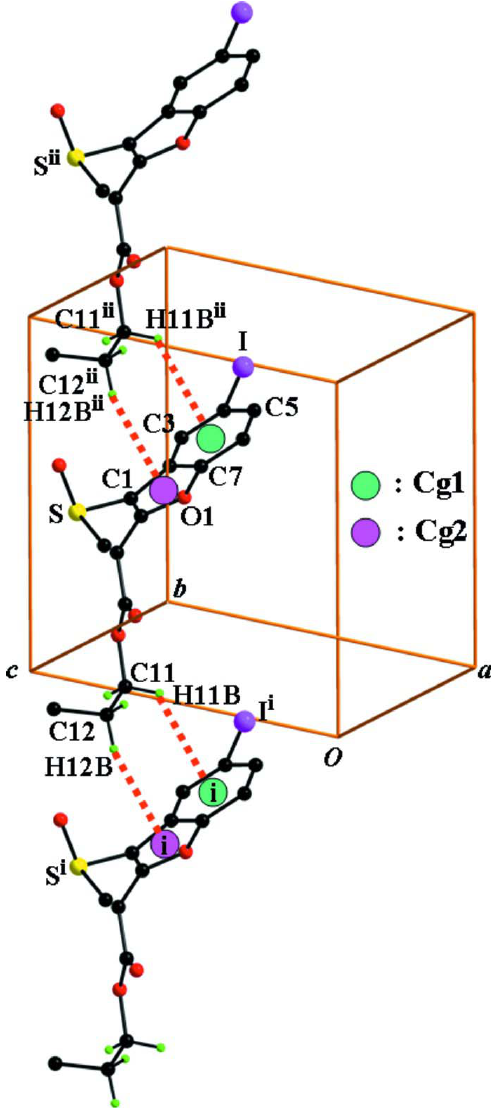
Figure 2 C—H··· π interactions (dotted lines) in the title compound. Cg denotes the ring centroid.[Symmetry code: (i) x , y -1, z ; (ii) x , y +1, z